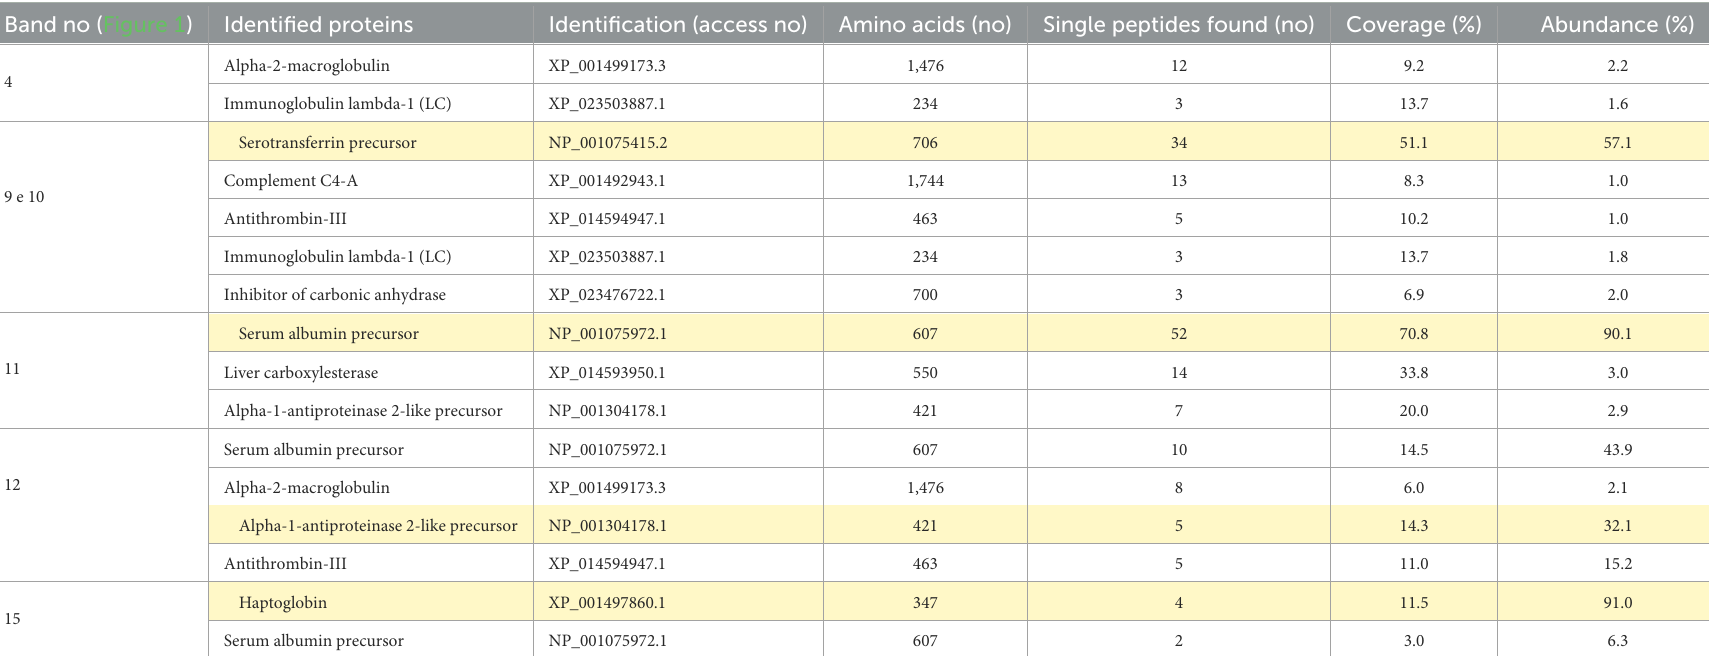
TABLE 2 Identification of Equus caballus serum proteins by liquid chromatography coupled to mass spectrometry (LC-MS/MS), based on the chemical digestion of five bands of interest in polyacrylamide gels